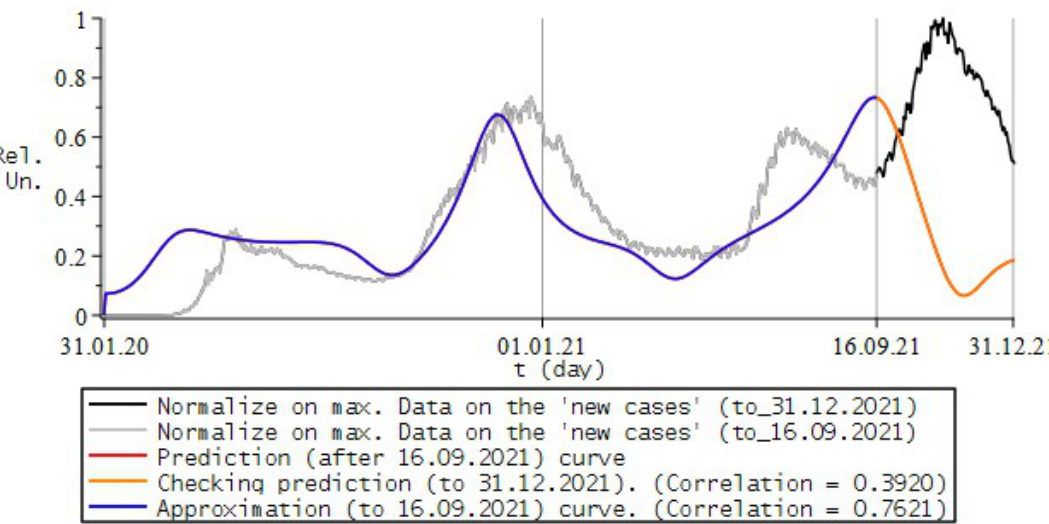
Figure 16. Russian Federation. Model curve: (blue)—approximation, with a correlation coefficient: 76.2%; (red)—forecast, through 31 December 2021; (orange)—verification of the forecast with the correlation coefficient: 39.2%. The red curve and the orange curve are obviously the